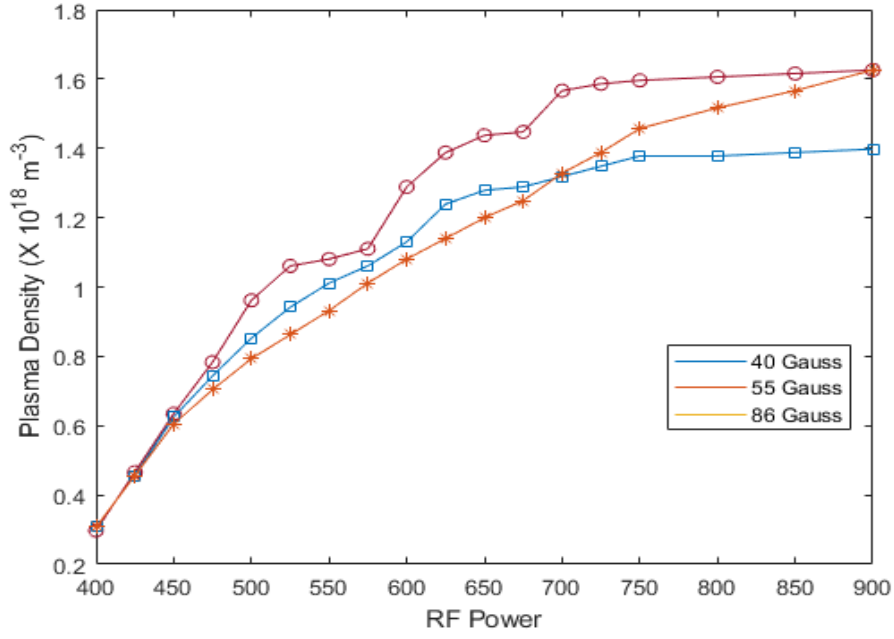
Figure 2. Variation of ion saturation current with increasing RF power (Watts) at 6-mTorr